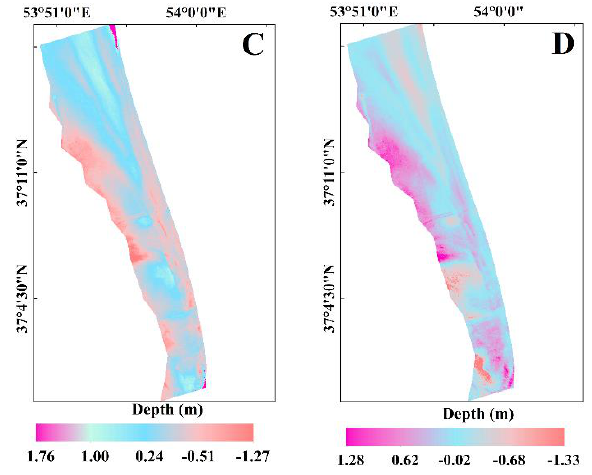
Figure 4. Two different maps (the difference of predicted depth from known depth) by bands 2, 3 and 4 without logarithmic transformation (C); with logarithmic transformation (D).